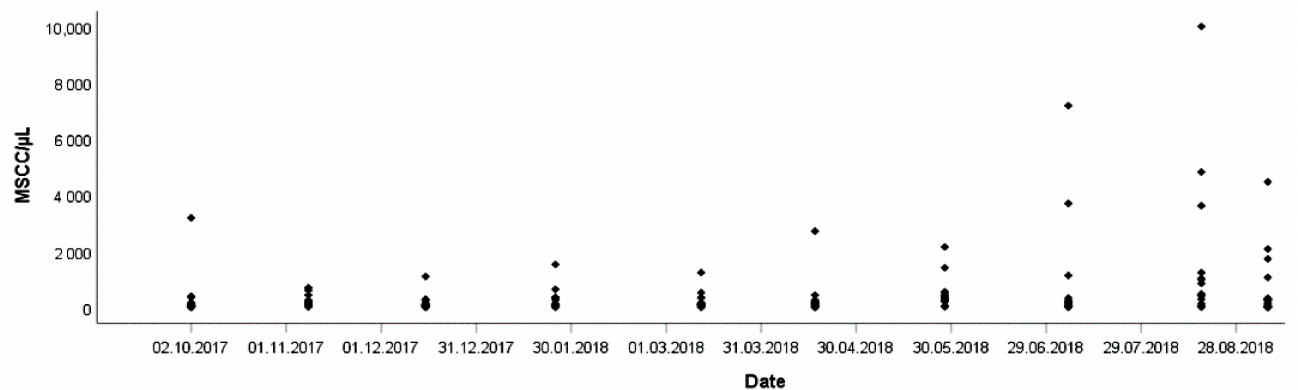
Figure 1. Increase of MSCC from July until September 2018 (data from individual monthly test day SCC).